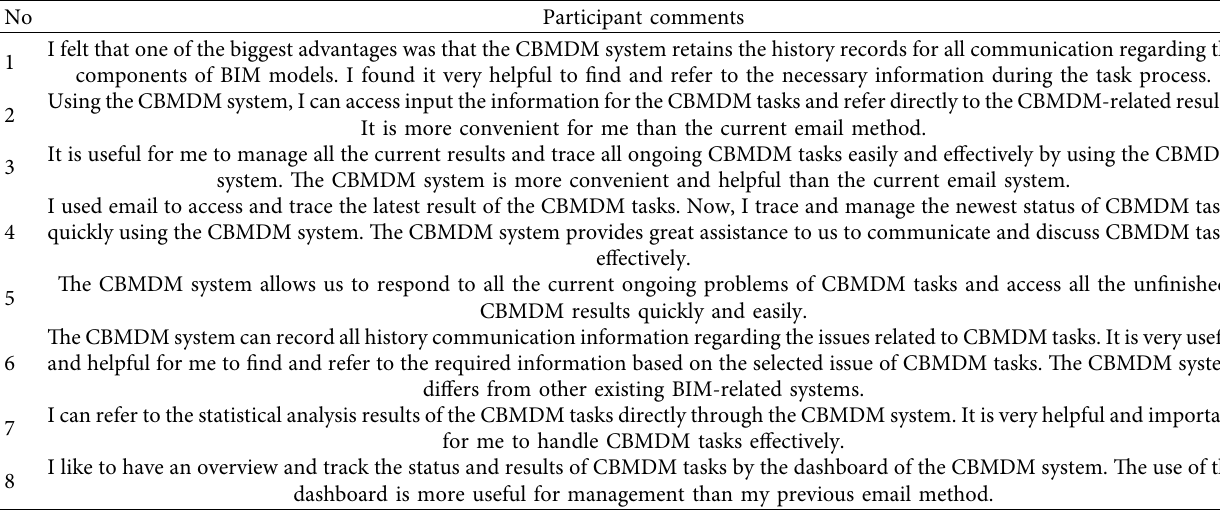
Table 3: Evaluation comments from participating BIM engineers.